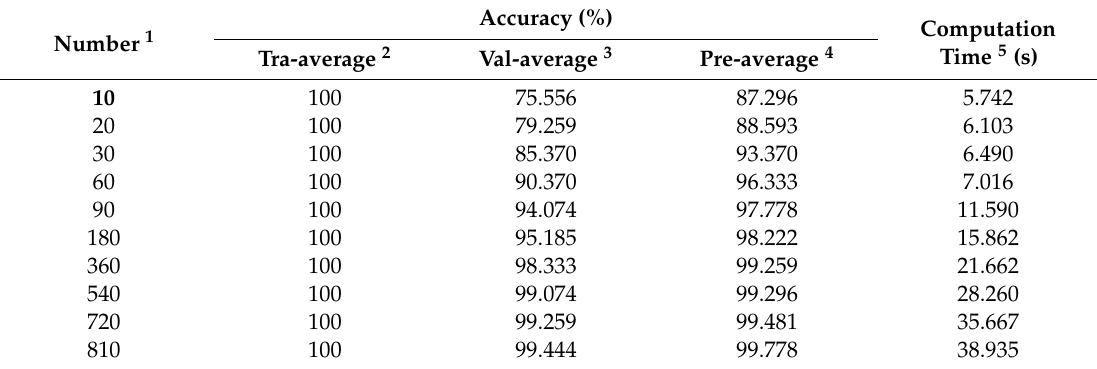
Table 2. Object-wise CNN models used to predict average spectra.